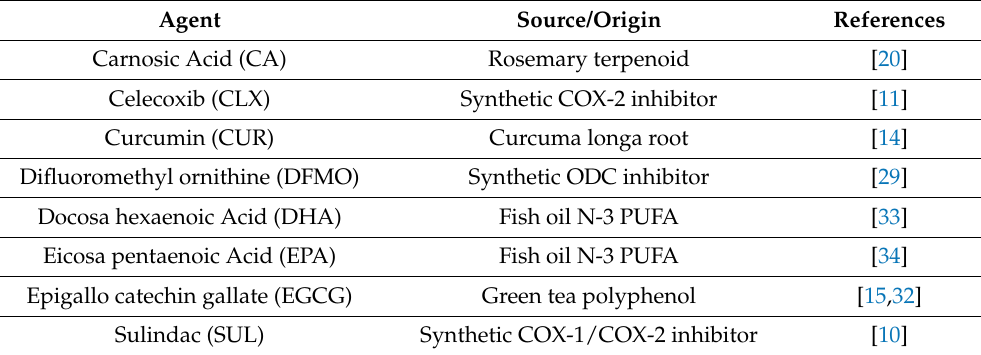
Table 2. Test Agents.